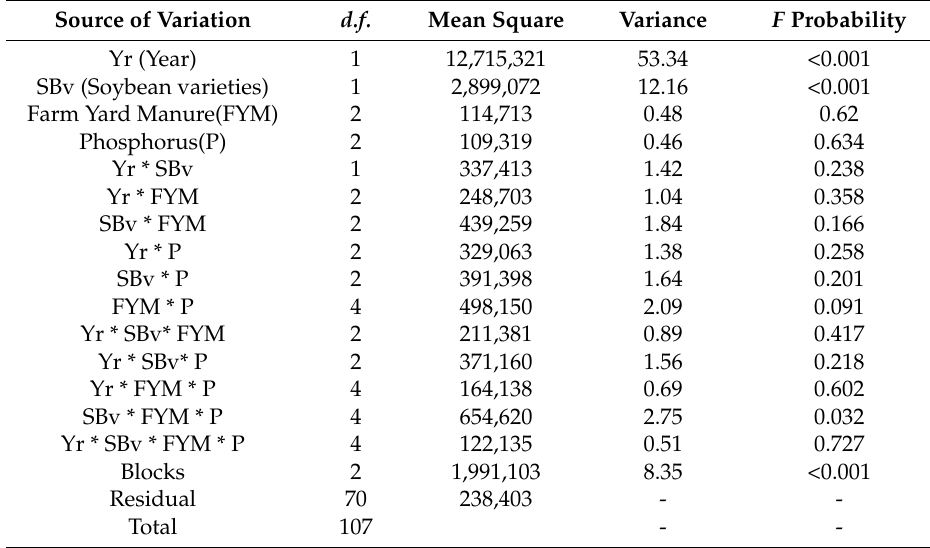
Table 2. Combined ANOVA table for yield performance of soybean as affected by varieties, FYM and P fertilizers’ application in the 2012 and 2014 cropping seasons at Bako,